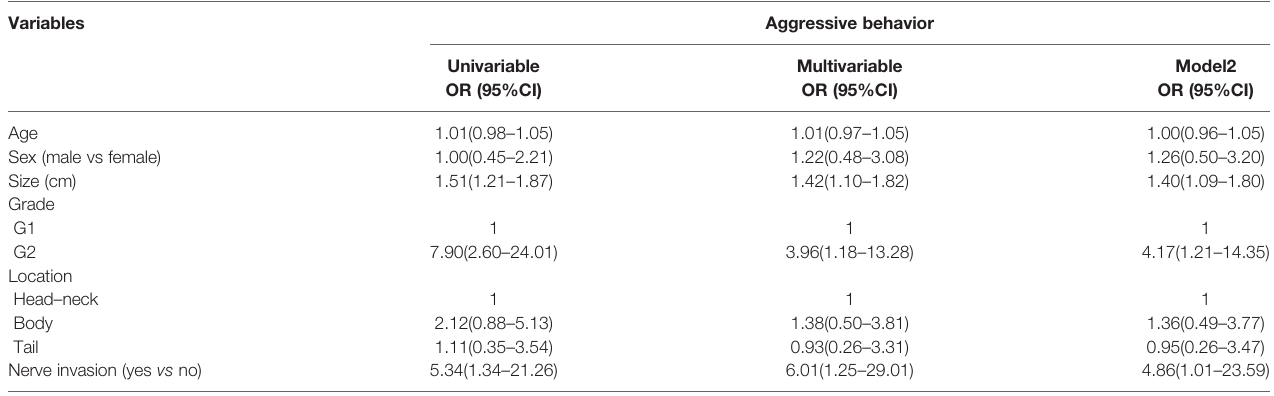
TABLE 3 | Logistic regression analysis in patients with G1/G2 PNET (n =